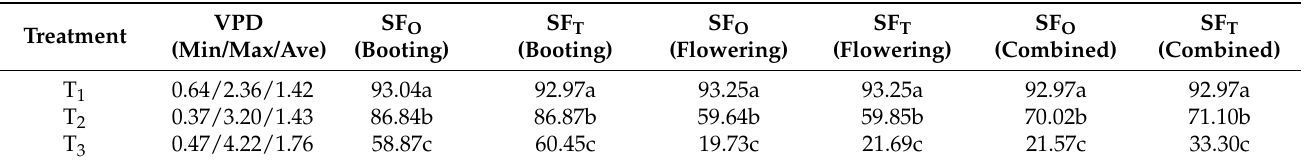
Table 4. Relationship between average spikelet fertility of both durations and both cultivars and vapor pressure deficit (VPD). SF O denotes the spikelet fertility of original tillers, and SF T denotes the spikelet fertility of total tillers. Different letters indicate significant differences at 0.05